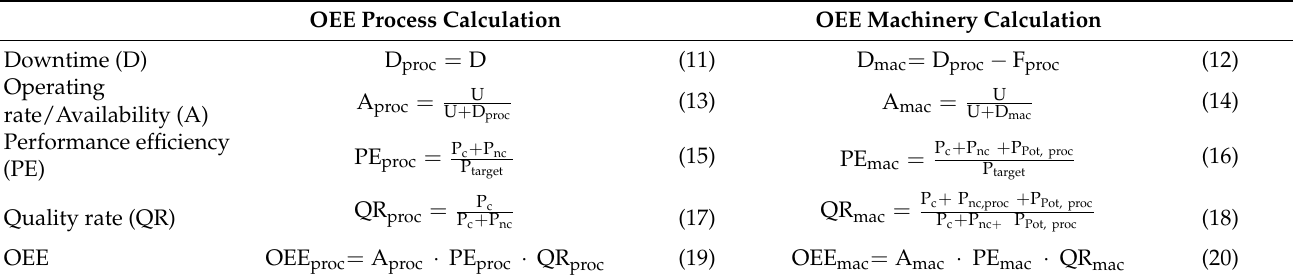
Table 4. Representation of the OEE measurement methodologies, distinguishing between human and technical